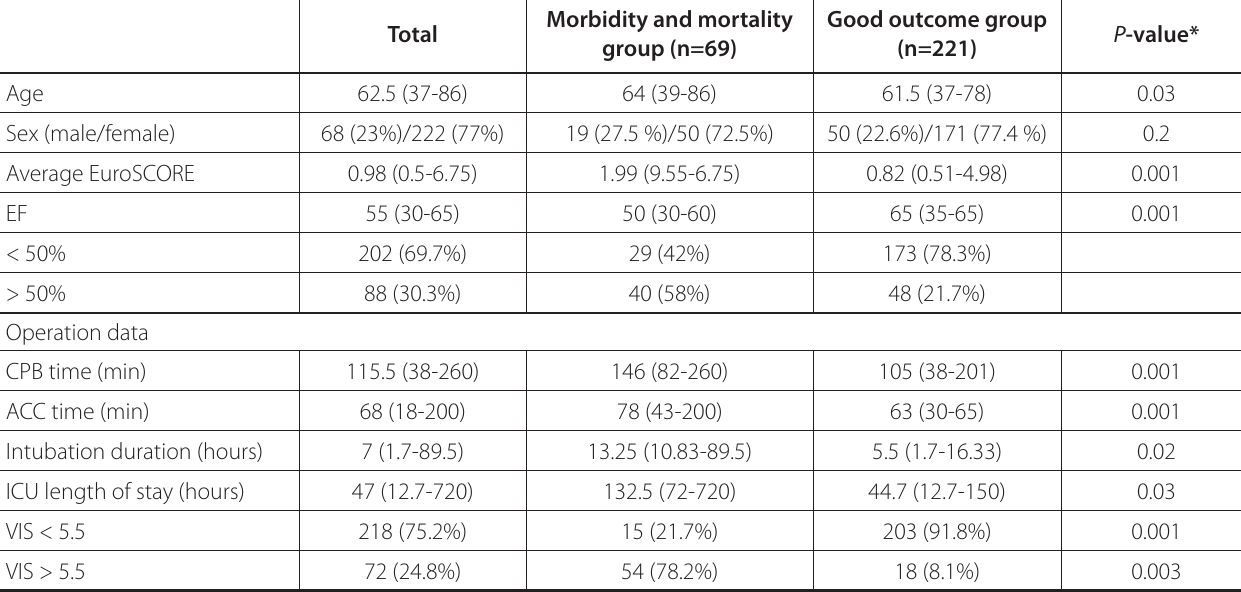
Table 1 . Clinical characteristics of research